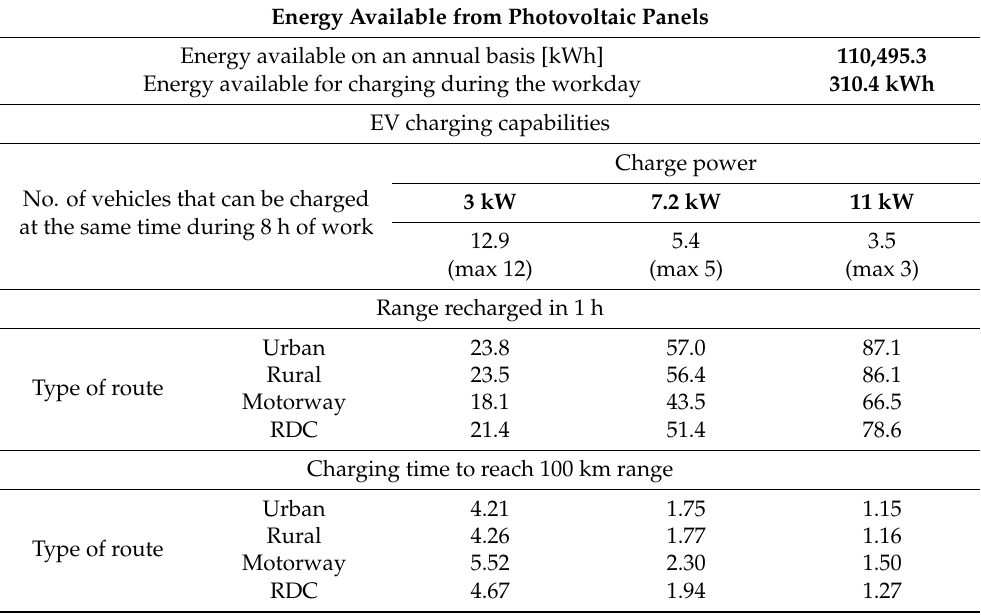
Table 4. Estimated parameters for charging an EV vehicle using PV installation of the nZEB building. Energy Available from Photovoltaic Panels Energy available on an annual basis [kWh] 110,495.3 Energy available for charging during the workday 310.4